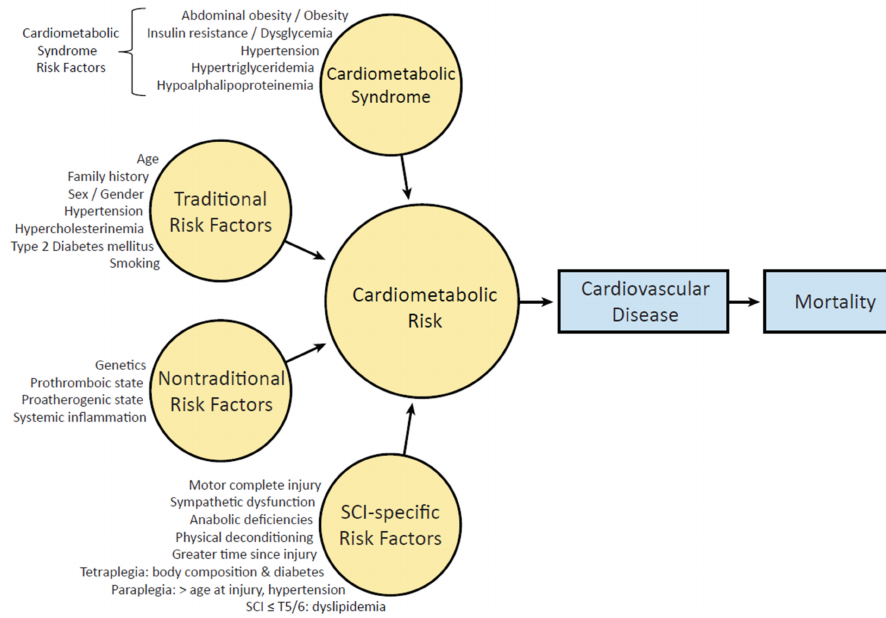
Figure 1. Interconnected component risk factors of cardiometabolic risk and cardiometabolic syn- drome and their progression to cardiovascular disease and mortality.